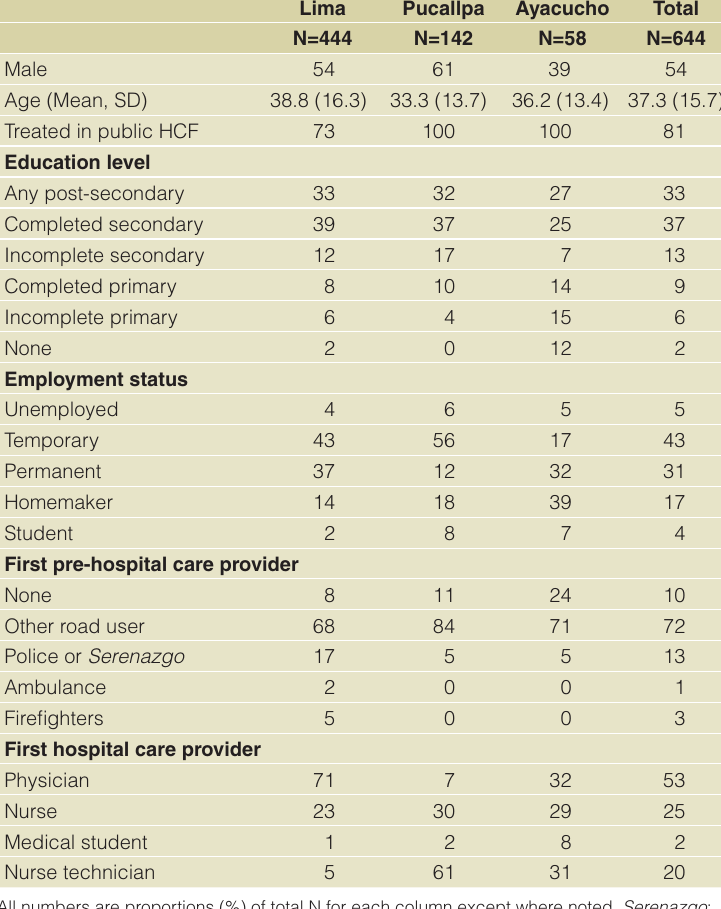
Table 1. Descriptive statistics of participants.